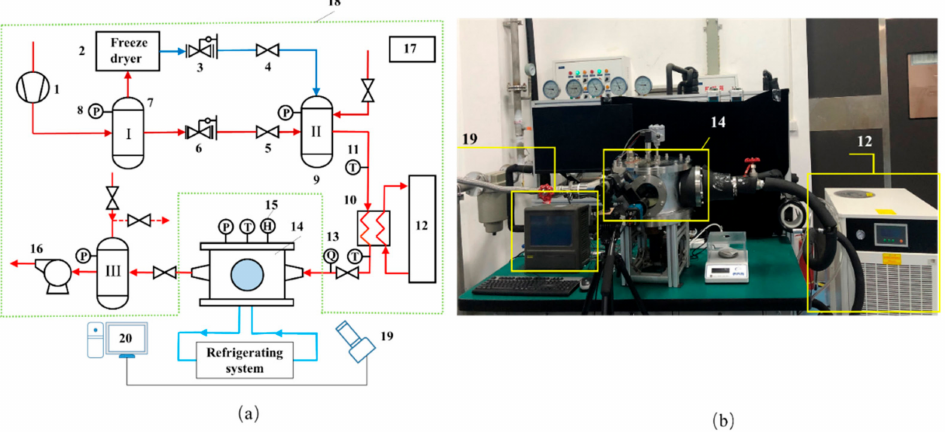
Figure 1. ( a ) The flowchart and ( b ) test rig of the visualized pressure adjustable frosting test, which consists of 1. compressor, 2. freeze drying equipment, 3. electropneumatic proportional valve, 4. gate valve, 5. gate valve, 6. electropneumatic proportional valve, 7. buffer tank I, 8. pressure transducer, 9. buffer tank II, 10. heat exchanger, 11. temperature sensor, 12. chiller, 13. flowmeter, 14. visualized cavity, 15. hygrometer, 16. vacuum pump, 17. atmospheric environment, 18. humid air conditioning system, and 19. data collecting